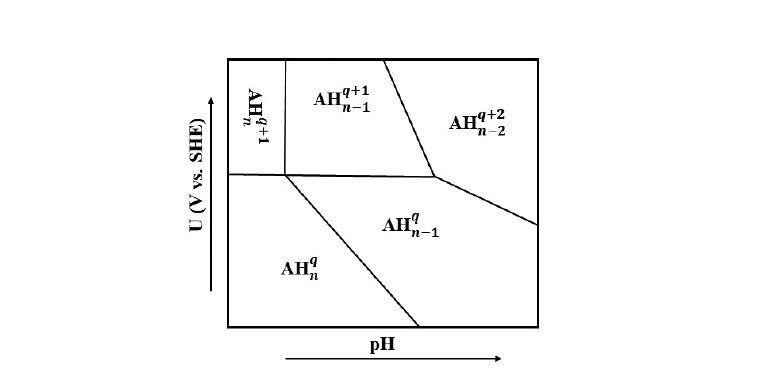
Fig. 3. – Computational potential- p H diagram describing the most stable structures based on the potential and p H